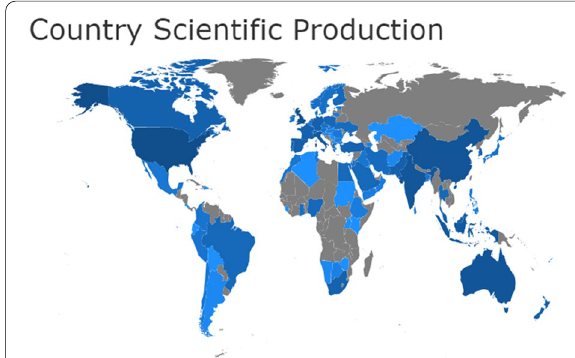
Fig. 1 Geographic dispersion of publications on Covid‑19 and performance